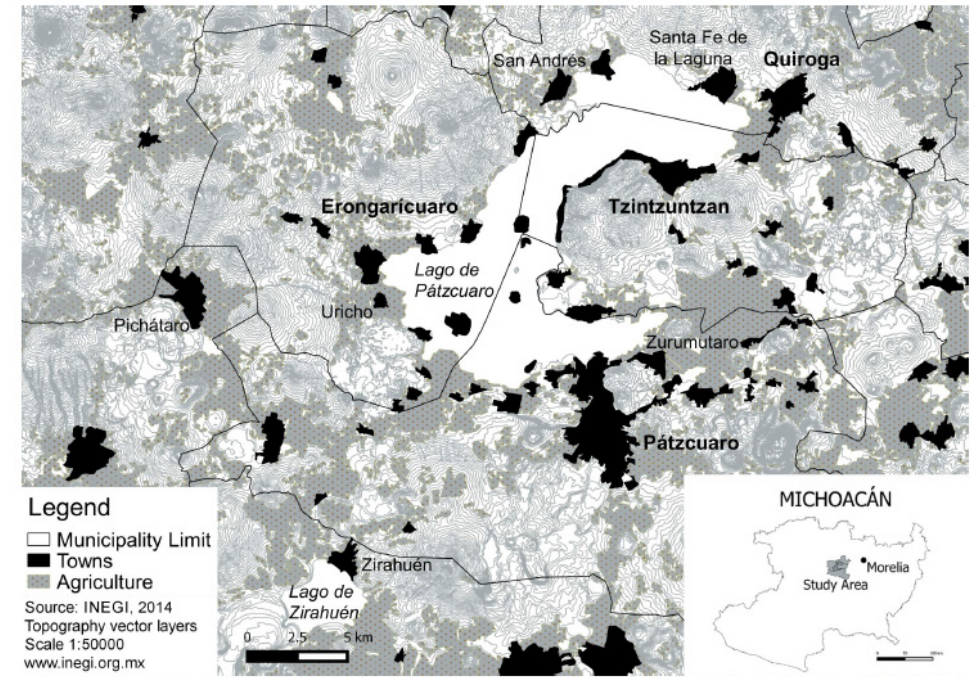
Figure 1. Map of the study area.